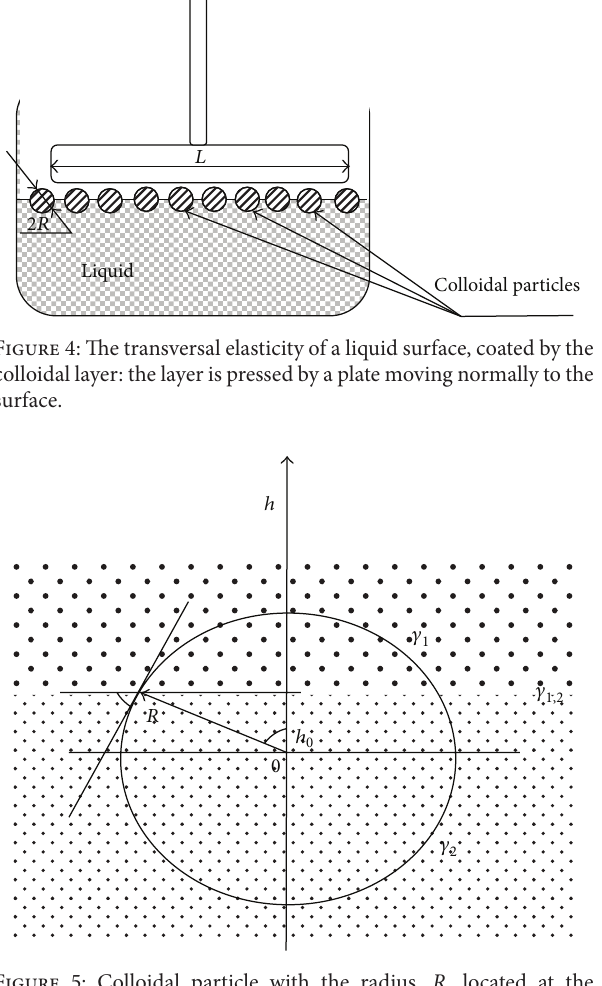
Figure 5: Colloidal particle with the radius, 𝑅 , located at the interface separating two